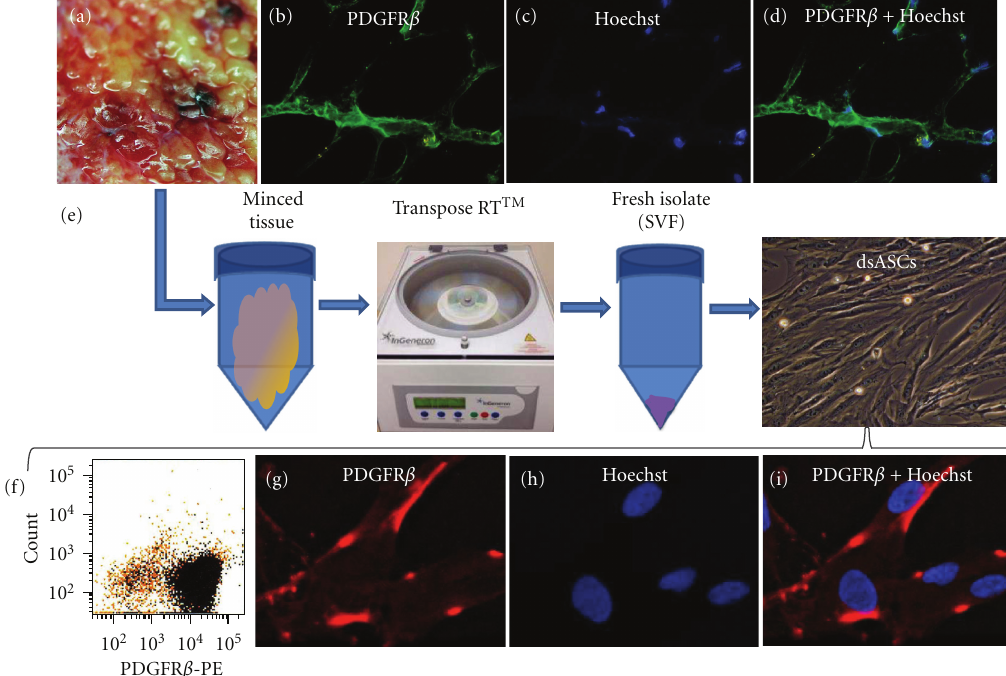
Figure 3: (a) Discarded burn skin. (b–d) Immunohistochemical images of section from discarded skin biopsies: (b) stained with PDGFR β (Alexa fluor 488), (c) Hoechst for nuclei, and (d) overlay of PDGFR β and Hoechst. (e) Stem cell isolation process from the adipose tissue layer of discarded burn skin (dsASCs) using the Transpose RT tissue processing system. (f) Fluorescent-activated cell sorting (FACS) analysis of P1 dsASCs stained with phycoerythrin-labeled PDGFR β . (g–i) Immunocytochemical images of P1 dsASCs: (g) stained with PDGFR β (Alexafluor 594), (h) Hoechst for nuclei, and (i) overlay of PDGFR β and Hoechst. Original magnification: × 200 (b–d and dsASCs in (e)) and × 600 (g–i).